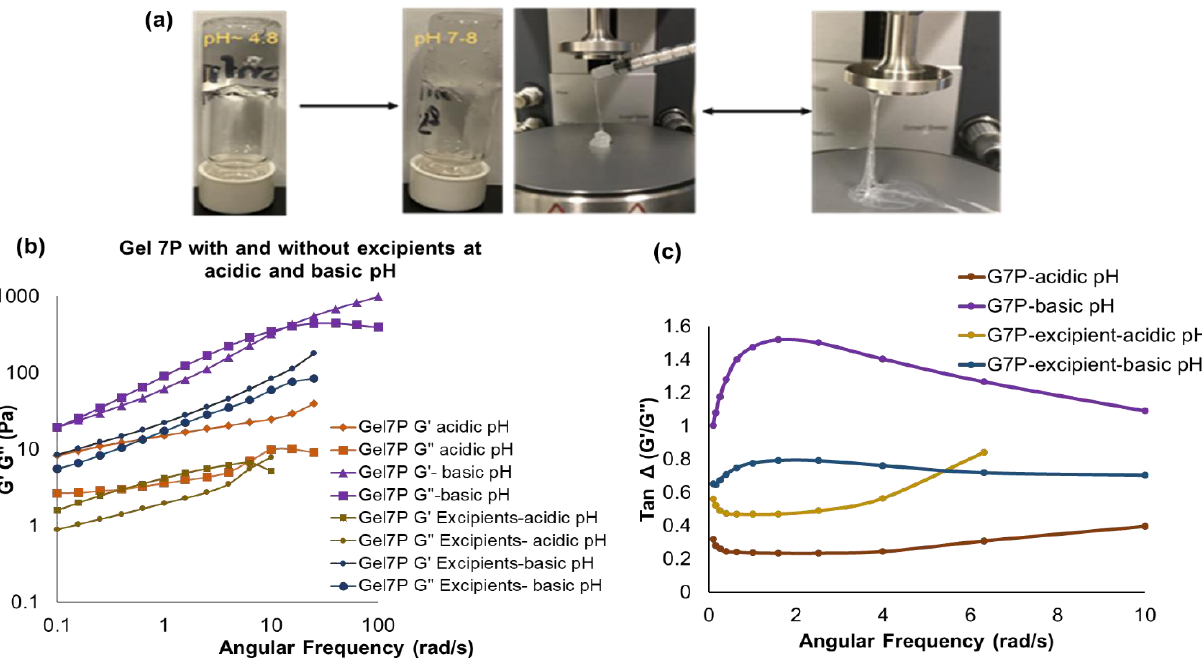
Figure 7 . ( a ) Physical observations with C i -PVA-BA gel 7P exhibiting a soft syringeable (no spinnbarkeit) characteristic at acidic pH (~4.8), but a thicker viscoelastic gel with spinnbarkeit behavior was observed when the pH was increased to 7–8. ( b ) Frequency sweep results of Gel 7P with and without excipients at acidic and basic pH. ( c ) Tan Δ plots for gel 7P under acidic and basic conditions.